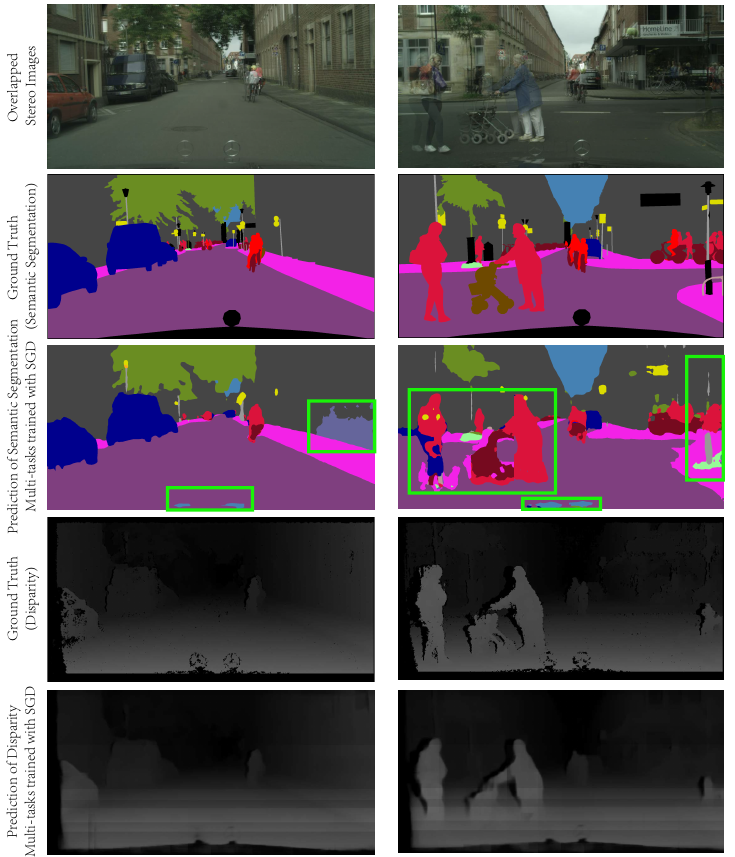
Figure 2. Failure cases of joint learning of semantic segmentation and disparity using the original SGD optimization algorithm. Because the sub-task of disparity has a much larger gradient during training, the network tends to perform a better disparity but with a very poor semantic